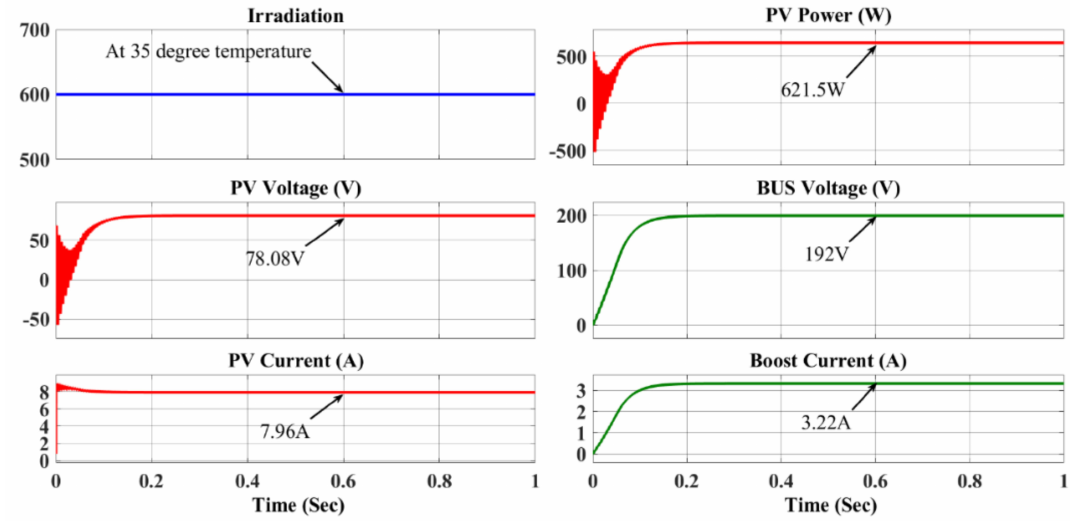
Figure 12. PV measurements, boost voltage, current, and PV output Power at an irradiance of 600 W/m 2 and temperature of 35 ◦ C for PV 3